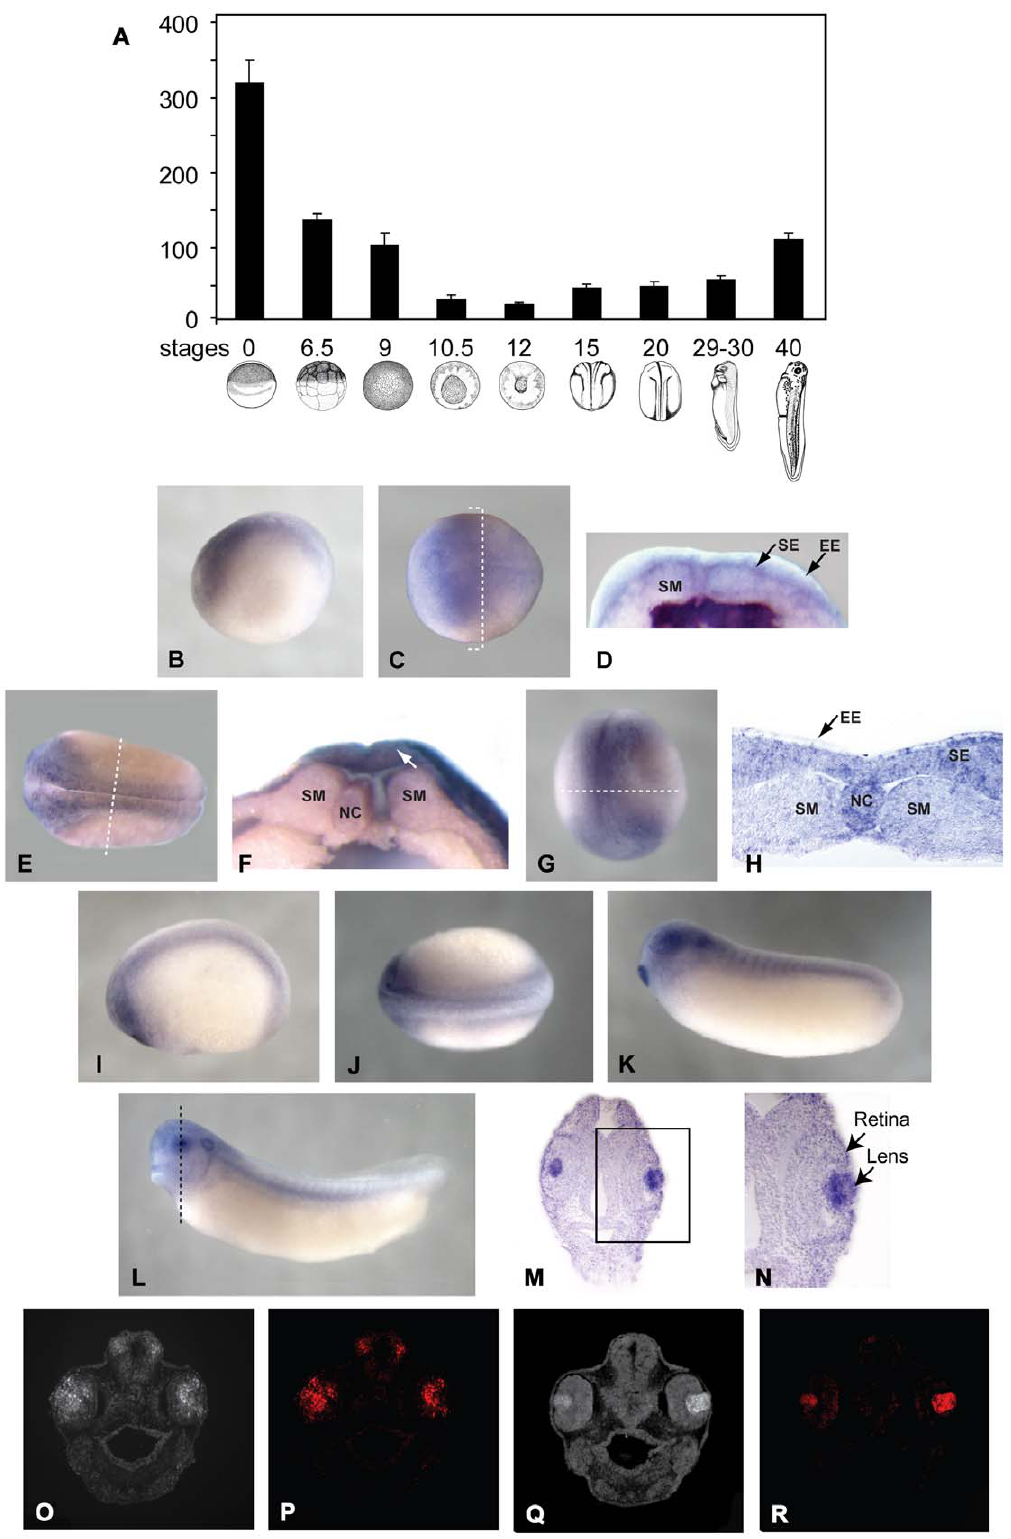
Figure 2 . Expression of SPC7 mRNA in Xenopus embryos at different developmental stages . (A) Real-time PCR. (B-N) Whole mount hybridization in situ (in panels B, C, E, and I-L, anterior is to the left. Dotted lines in C, E, G, and L indicate the approximate plane for images in D, F, H, and M, respectively). (B-C) Lateral (B) and dorsal (C) views of a stage 13 embryo showing staining in the early neural plate. (D) Hemisected stage 13 embryo displaying detectable expression of SPC7 in the sensorial layer of the neuroectoderm, but not in the underlying somitogenic mesoderm. (E) Dorsal view of stage 16 embryo showing SPC7 staining in the neural folds and presumptive eye field. (F) hemisected midneurula (stage 16) showing